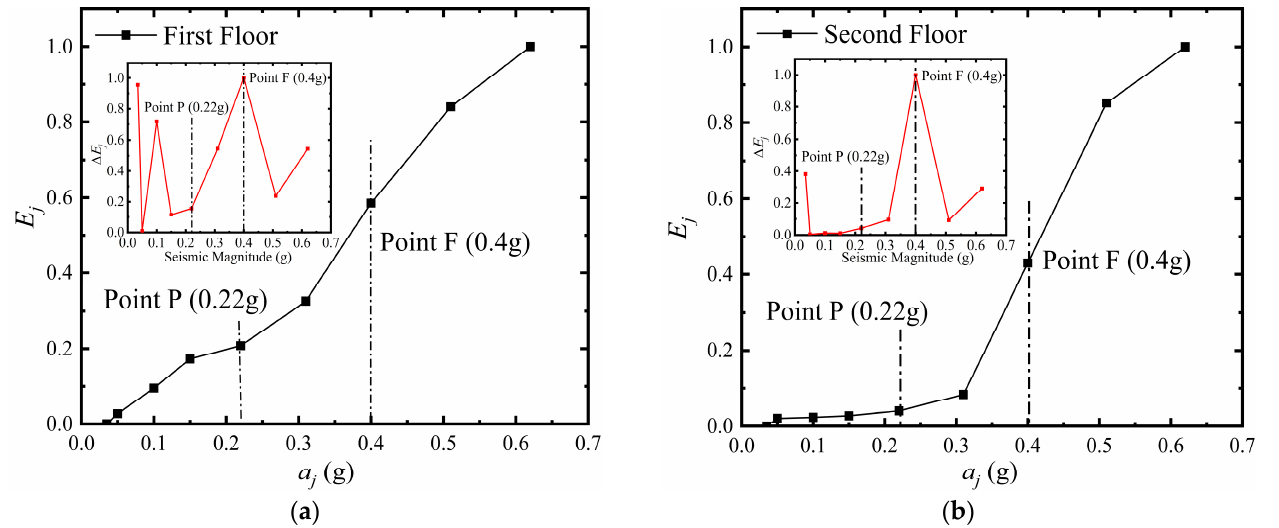
Figure 7. The characteristic curves and the mutation points of the 1st and 2nd floors. ( a ) the 1st floor; ( b ) the 2nd floor.